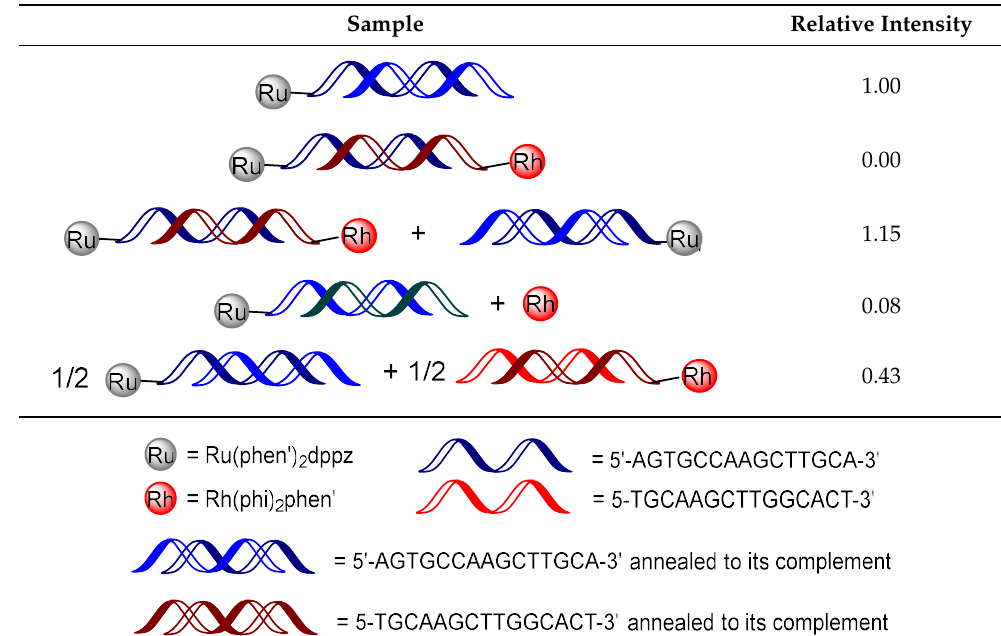
Table 2. Luminescent lifetimes of tris(phenanthroline)metal-DNA complexes. Samples were dissolved in buffer (5 mM tris, 50 mM NaCl, pH 7.2) to ≤5 µM and experiments performed at 10 °C to ensure duplex stability [74].